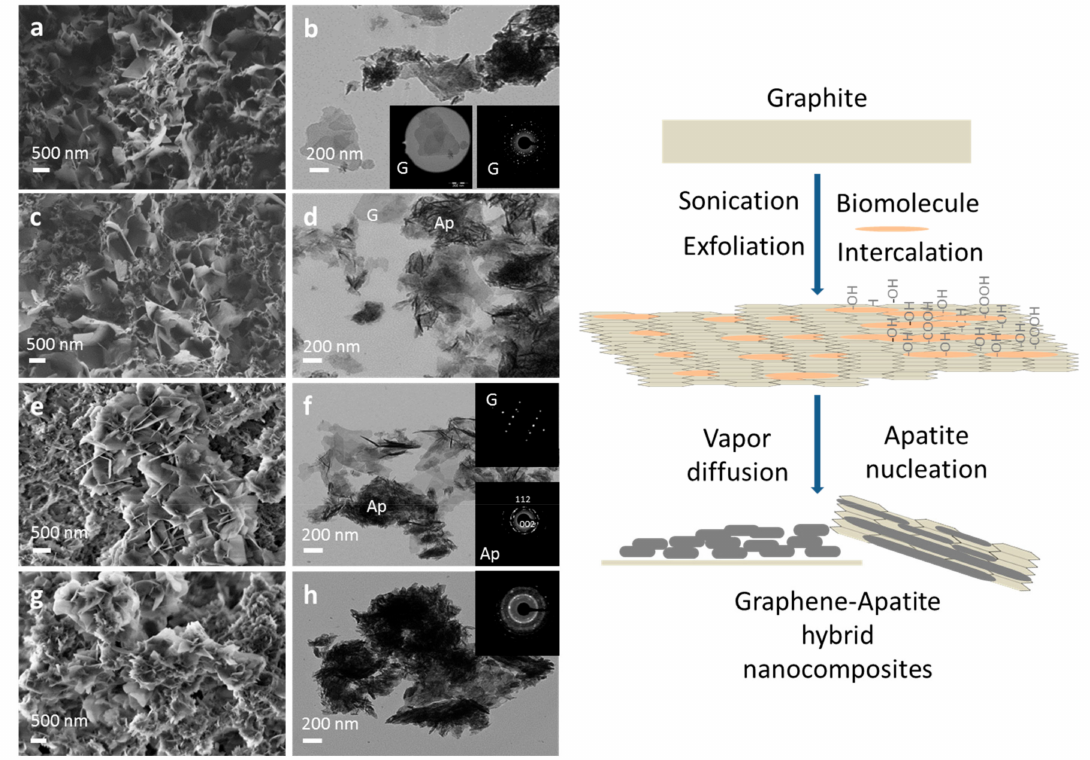
Figure 4. Left panel . ( a , c , e , g ) VPSEM and ( b , d , f , h ) TEM micrographs of nanocrystalline apatites nucleated by the VDSD method on graphene nanoflakes, prepared by liquid phase exfoliation in presence of Lys ( a , b ), Try ( c , d ), NAce ( e , f ), and Chi ( g , h ). Insets in the TEM micrographs are the